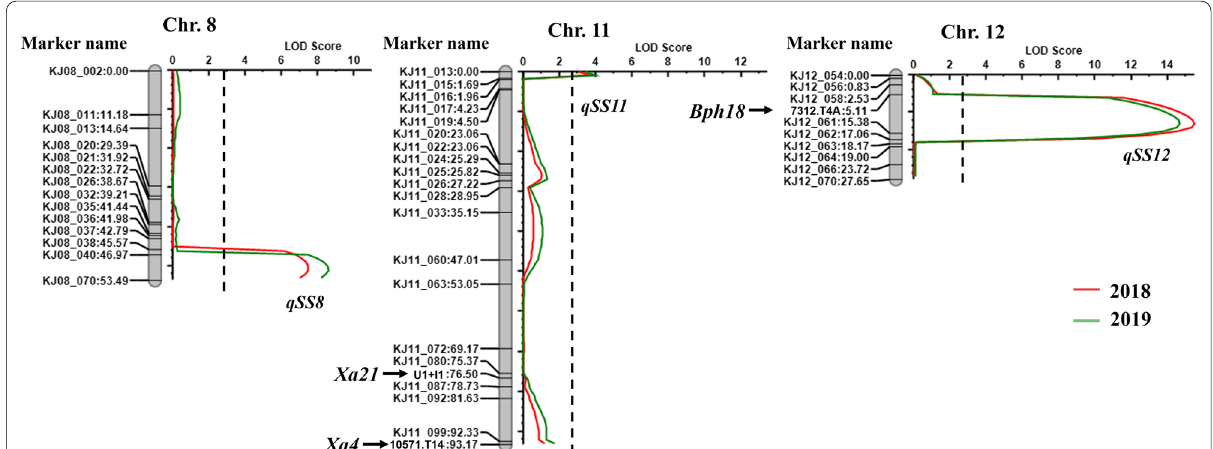
Fig. 2 Genetic map and analysis of QTLs for spikelet fertility on chromosomes 8, 11, and 12. Three QTLs, qSS8 , qSS11 , and qSS12 , were identified from 225 lines during 2018–2019. Three R ‑genes, Xa4 , Xa21 , and Bph18 , were located on chromosomes 11 and 12, and only Bph18 was within the region of qSS12 associated with spikelet sterility. The vertical dotted lines represent the threshold ratio (LOD test with 1000 repetitions